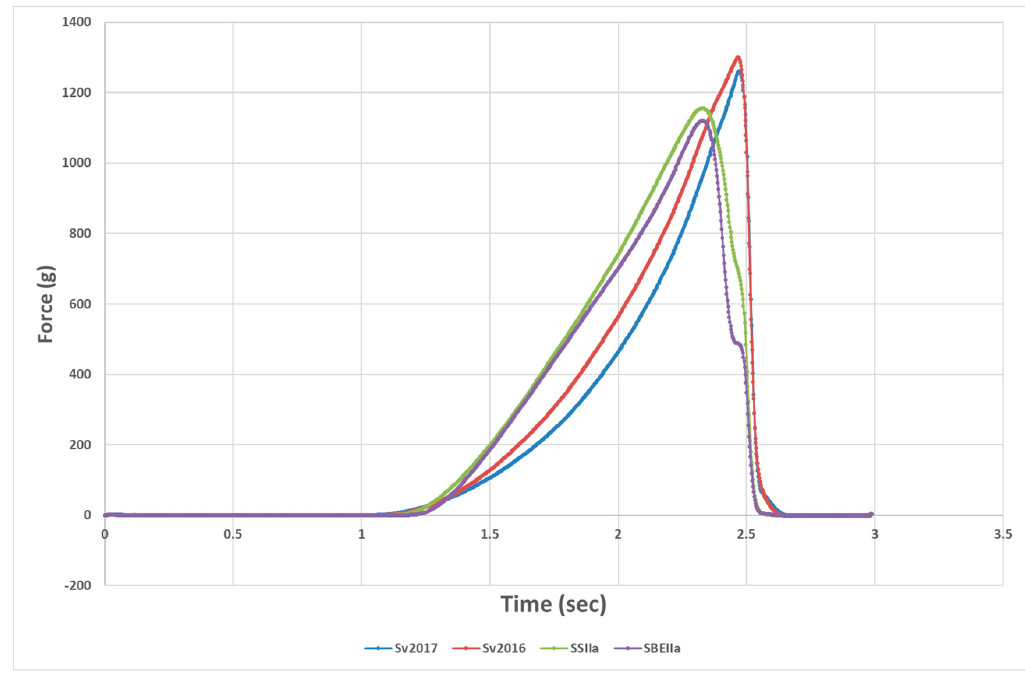
Figure 2. Typical profile for firmness measurement of HA and control genotypes.